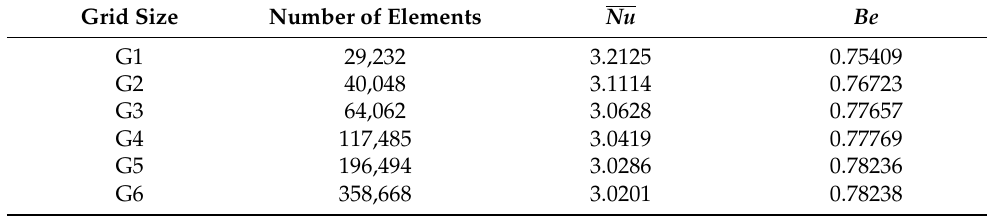
Table 1. Grid independence tests: Nu and Be for Ω = 15, Ri = 10, N = 3 and φ = 0.02. Table 1. Grid independence tests: (cid:1840)(cid:1873)(cid:3364)(cid:3364)(cid:3364)(cid:3364) and (cid:1828)(cid:1857) for Ω = 15 , (cid:1844)(cid:1861) = 10 , (cid:1840) = 3 and (cid:2038) = 0.02 .